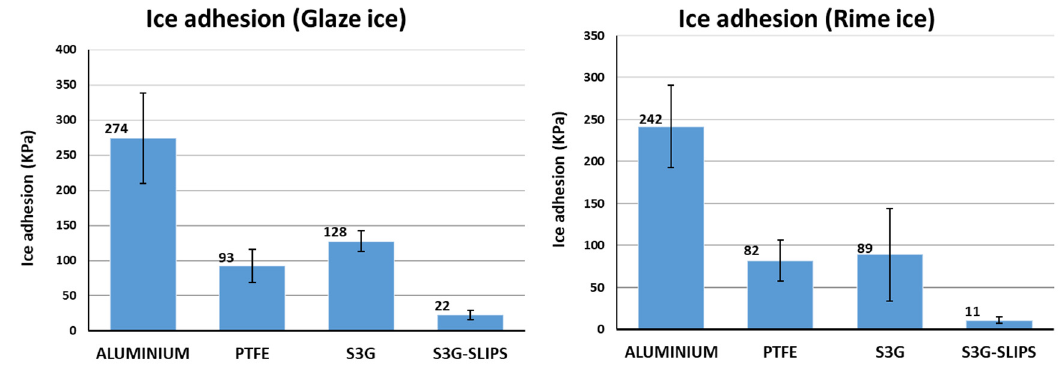
Figure 22. Graphs of ice adhesion tests after glaze and rime icing procedures in IWT.